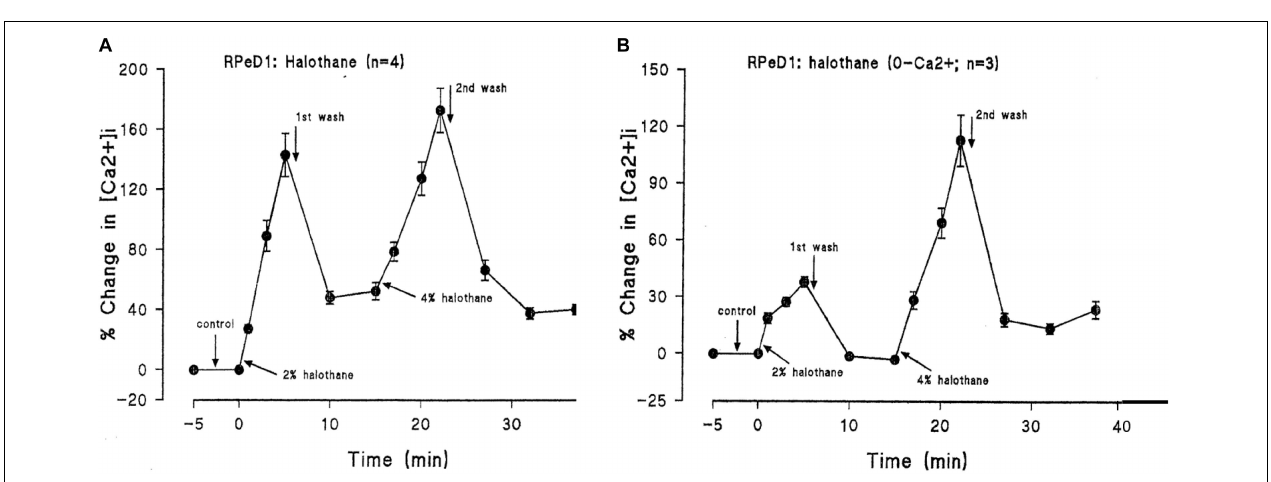
FIGURE 6 | Halothane modifies intracellular calcium concentration in RPeD1, (A) when vaporized into normal saline, (B) when vaporized into zero calcium saline (From Ahmed, 1995 – Reproduced under the Creative Commons License).